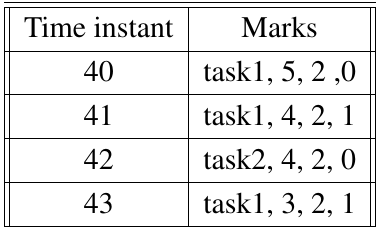
Table 1. Marks sequence on the CPU between times instants 40 and 43.